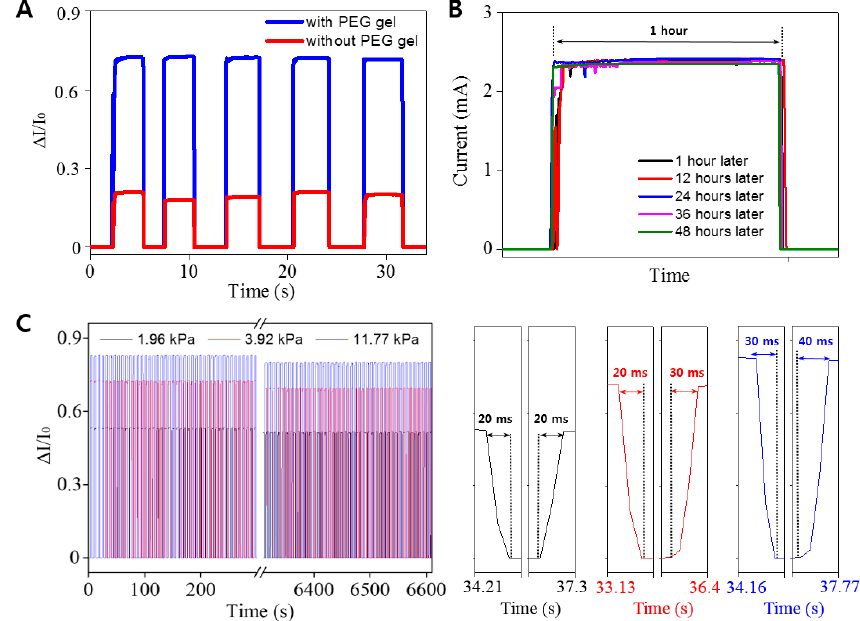
Figure 6. ( A ) Pressure sensing tests (pressure: 3.92 kPa) of resistive pressure sensors based on AgNW-PEG composite (blue line) and pure AgNW without PEG (red line). ( B ) Chronoamperometry curve of AgNW-PEG based pressure sensor under 3.92 kPa for 48 h. To demonstrate drift stability, measurements were conducted for 1 h at 1, 12, 24, 36, and 48 h after exercise. ( C ) Cyclability and